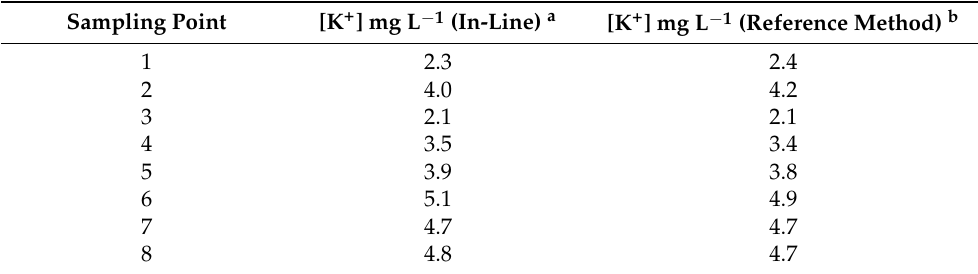
Table 5. Results obtained in the in-line monitoring of K + in a small-size dam. Sampling